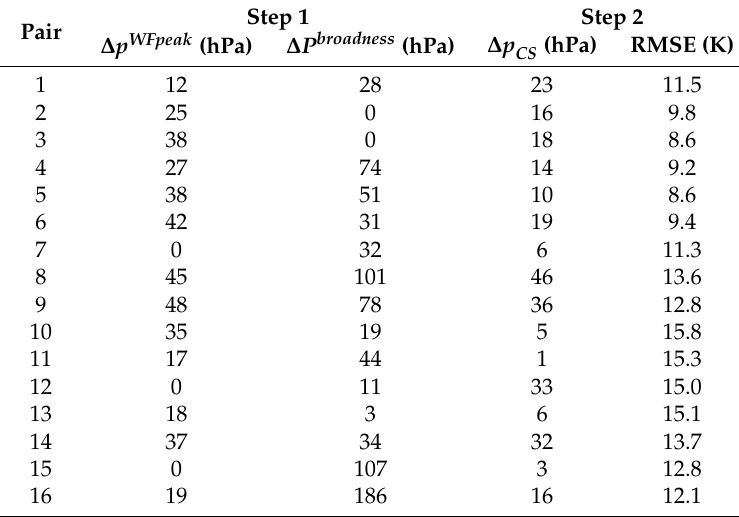
Table 2. Pair number, di ff erences of the WF peak ( ∆ p WFpeak ), WF broadness ( ∆ P broadness ), cloud-sensitive level ( ∆ p CS ) and the RMSE between the finally paired LWIR and SWIR HIRAS channels during two pairing steps. Step Pair